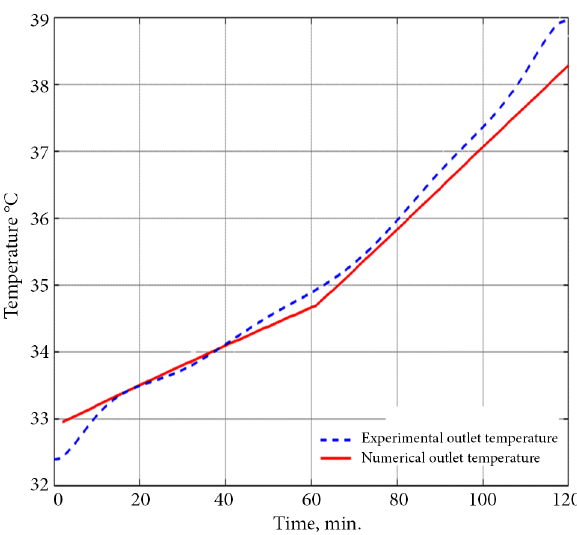
Figure 6. Comparison between numerical and experimental fluid inlet temperatures at the Solar PV/T collector inlet on Nov 2 nd